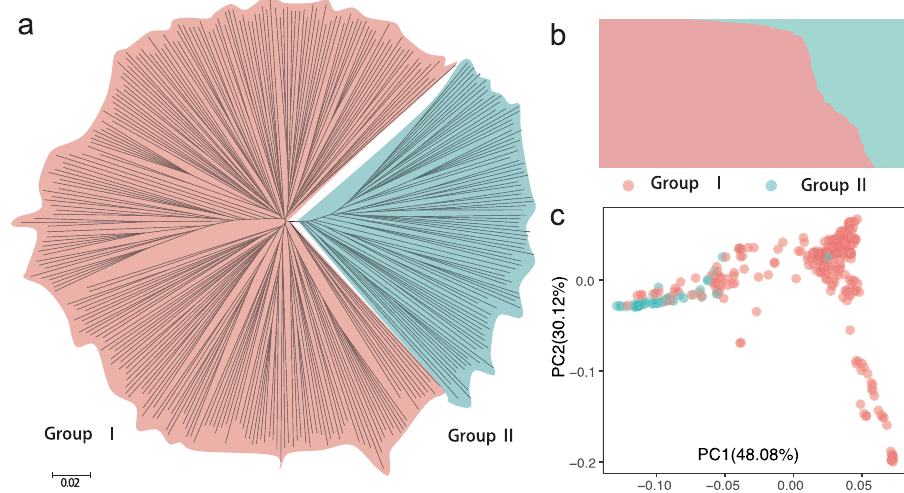
Fig. 1 Phylogenetic relationship and population structure of 312 sand pears. a Phylogenetic tree of sand pears. b Population structure of sand pears. K value is 2. c PCA of sand pears. Group I with red background corresponds to the Chinese group, and Group II with blue background indicates the Japanese and Korea group.